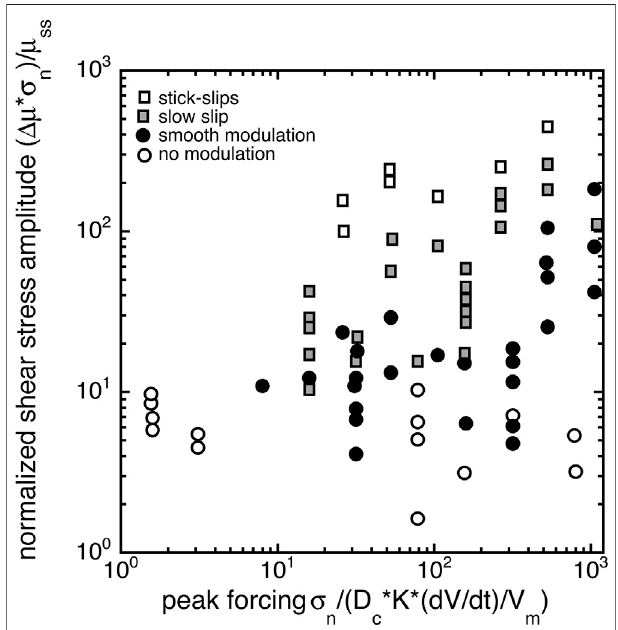
FIGURE 10 | Simple response phase diagram demonstrating the effect of forcing rate on the frictional response style and amplitude (normalized delta friction multiplied by normal